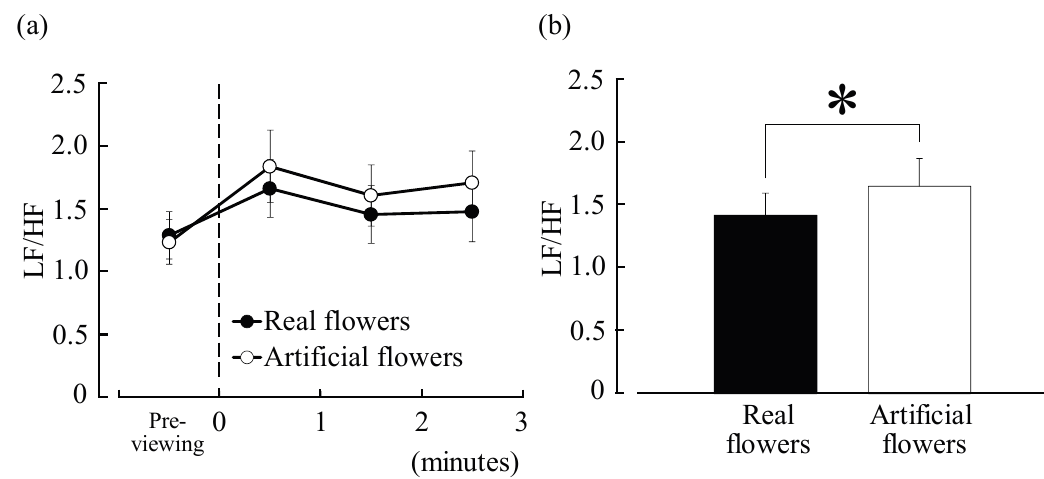
Figure 2. ( a ) Change in the low-frequency (LF)/high-frequency (HF) values of heart rate variability (HRV) between real and artificial flowers; ( b ) Comparison of LF/HF values of HRV between real and artificial flowers. n = 40, mean ± SE. * p < 0.05, determined by paired t -test (one-sided).